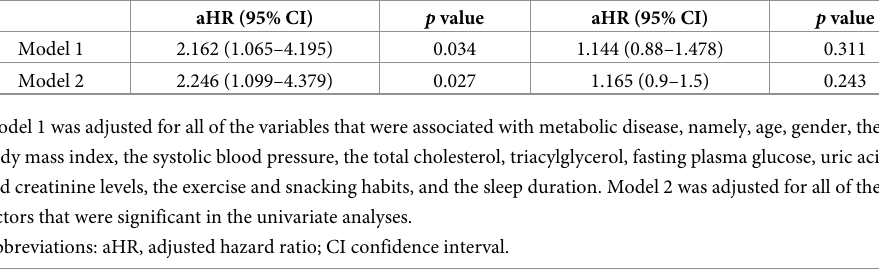
Table 5. Association between cigarette smoking and the onset of fatty liver disease.